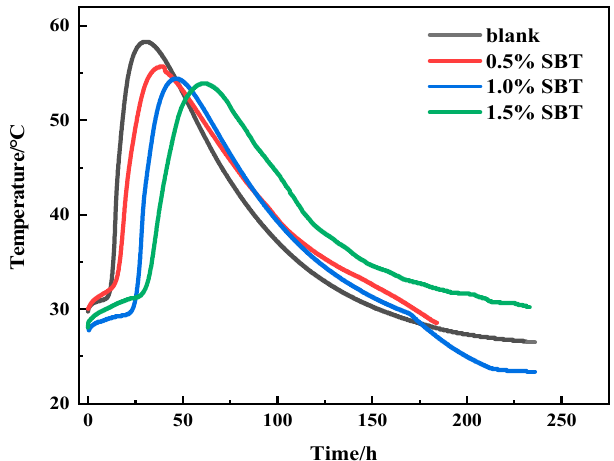
Figure 3. Internal temperature of concrete specimen.